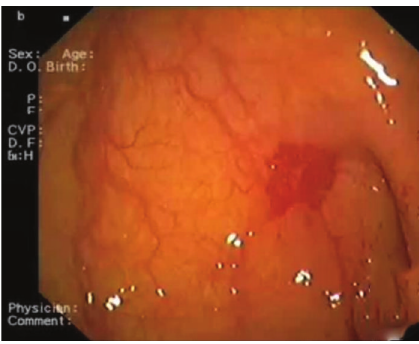
Figure 2: The site of angiodysplasia between the first and the second portion of the duodenum.